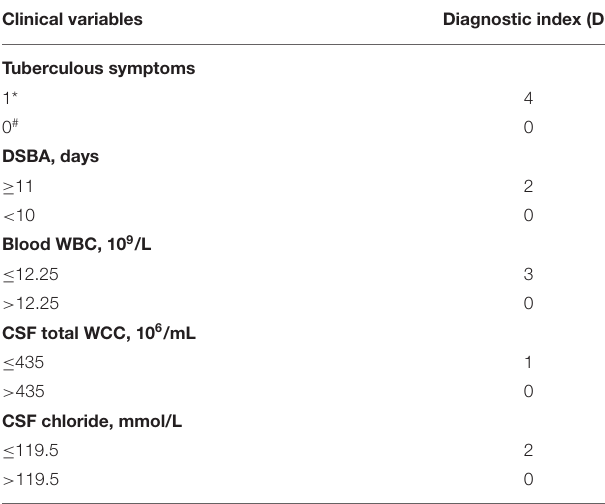
TABLE 5 | Weighted diagnostic index (DI) scores for dichotomized clinical variables used for diagnostic rule in admission. Clinical variables